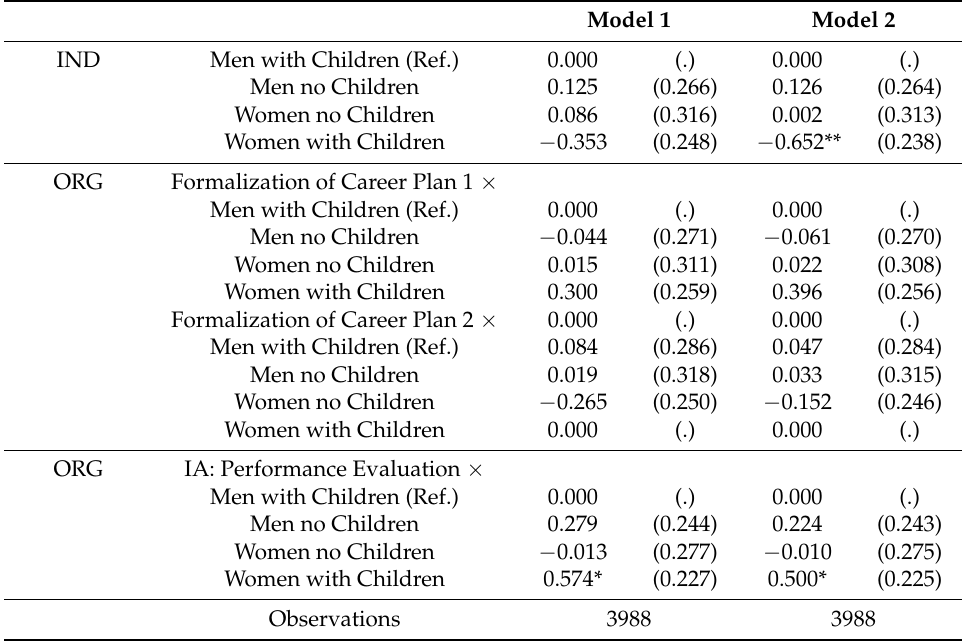
Table A3. Gender Gap in Claims-Making and Formalization of Human Resource Practices (results of logistic fixed-effects